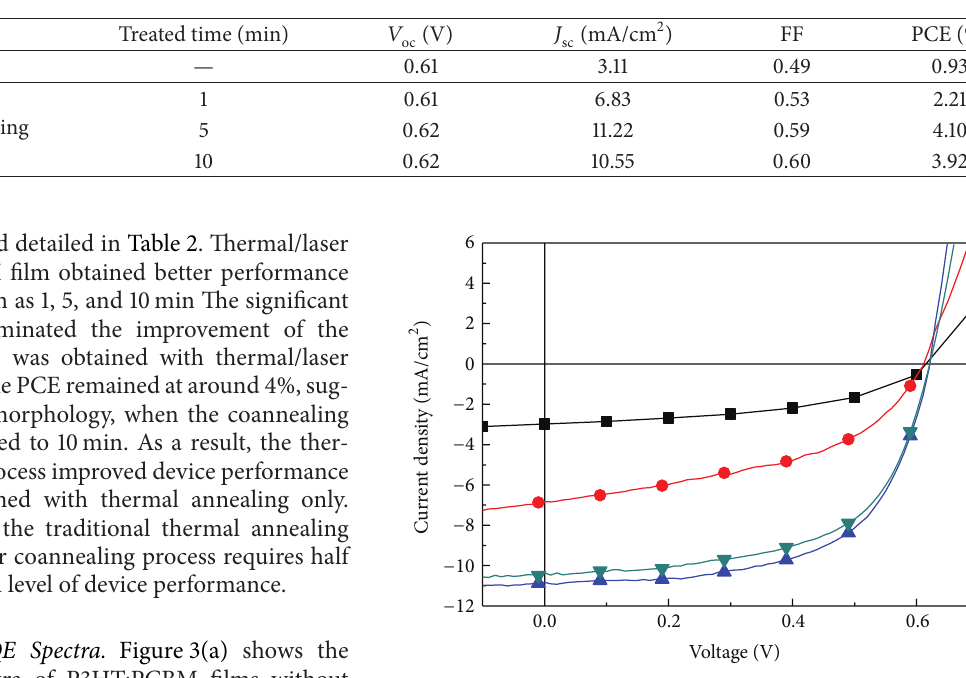
Table 2: The 𝑉 , 𝐽 , FF, and PCE of the devices with thermal/laser coannealing process under different duration. oc sc